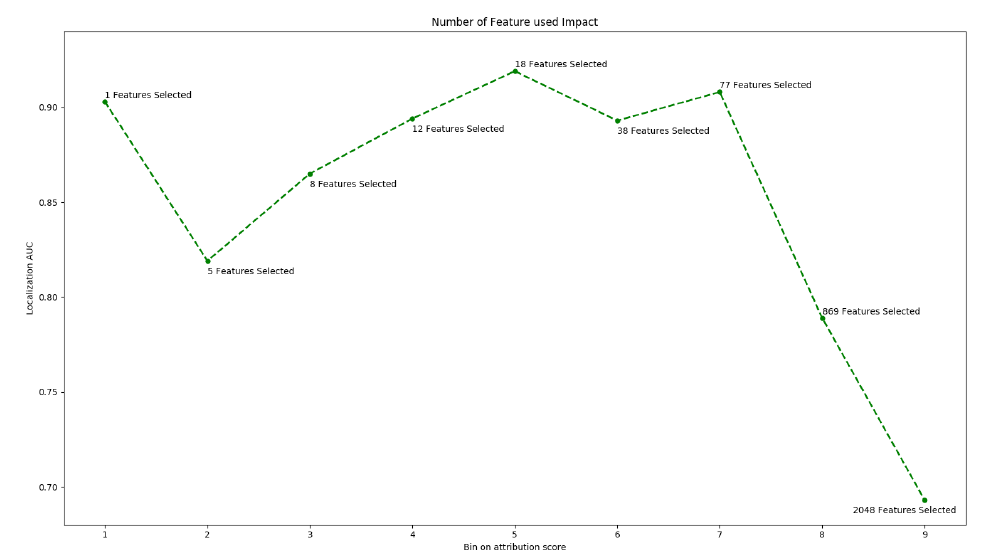
Figure 10. Impact of the number of selected features on localization AUC (between 0.7 and 0.9) for high numbers of